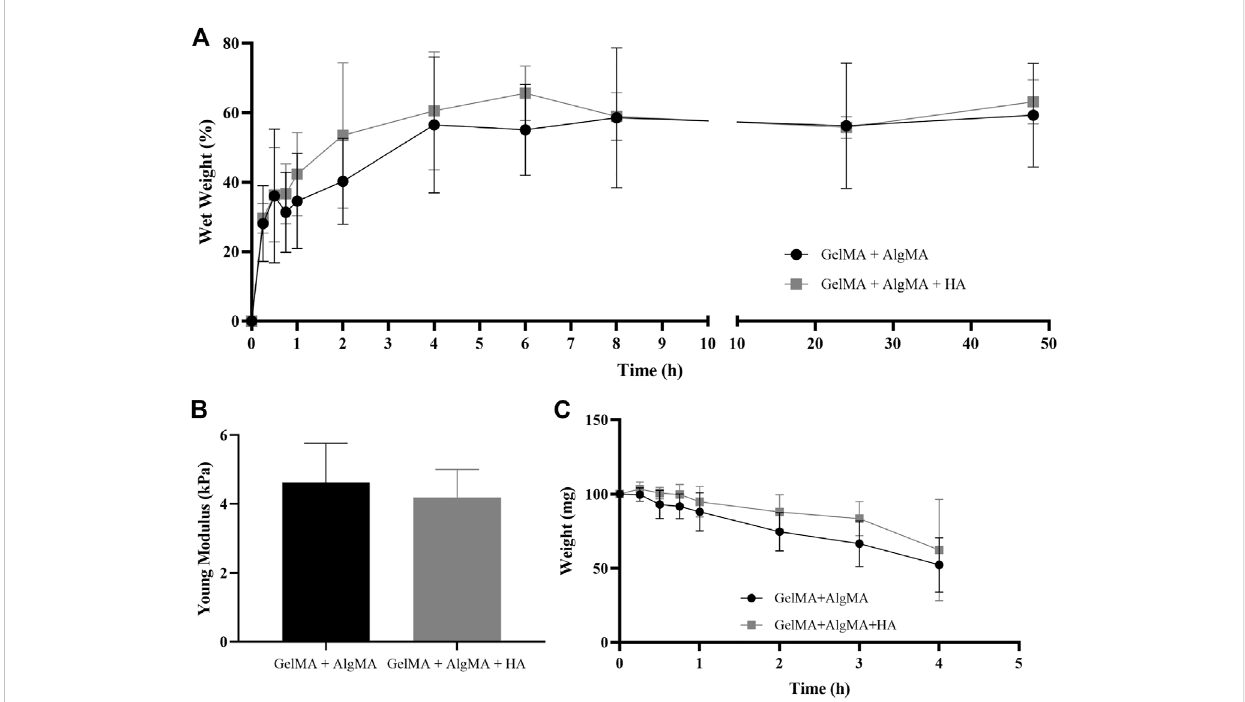
FIGURE 2 Physical characterization of the study formulation GelMA + AlgMA + HA and comparison with the control formulation of GelMA + AlgMA by examination of the results of (A) swelling, (B) compression, and (C) degradation assays.